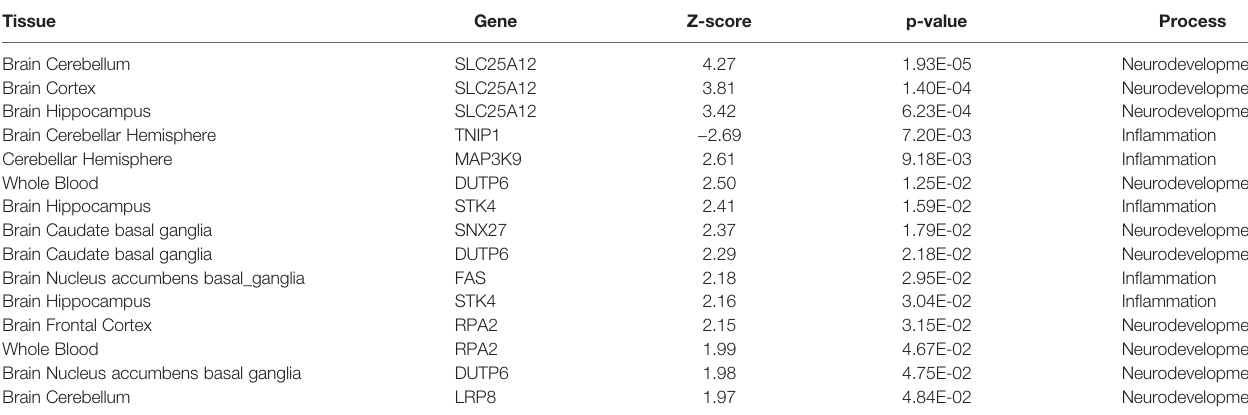
TABLE 1 | Schizophrenia TWAS association of the analysed in fl ammatory and neurodevelopmental genes in blood and brain tissues. Tissue